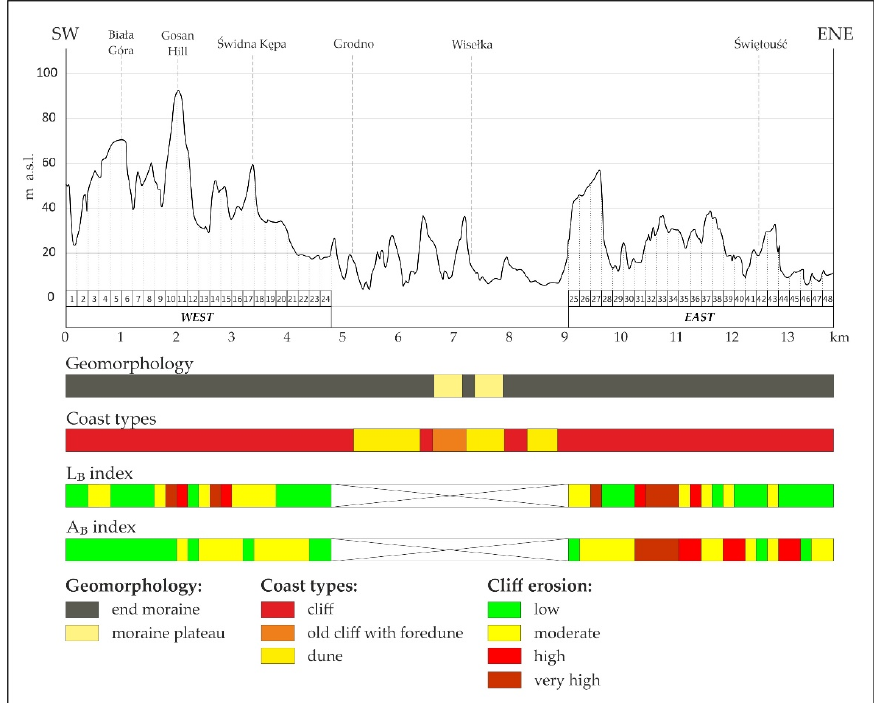
Figure 10. Spatial diversity of cliff erosion (in terms) on the background of coastal geomorphology and typology. Raw data source—Maritime Office in Szczecin.